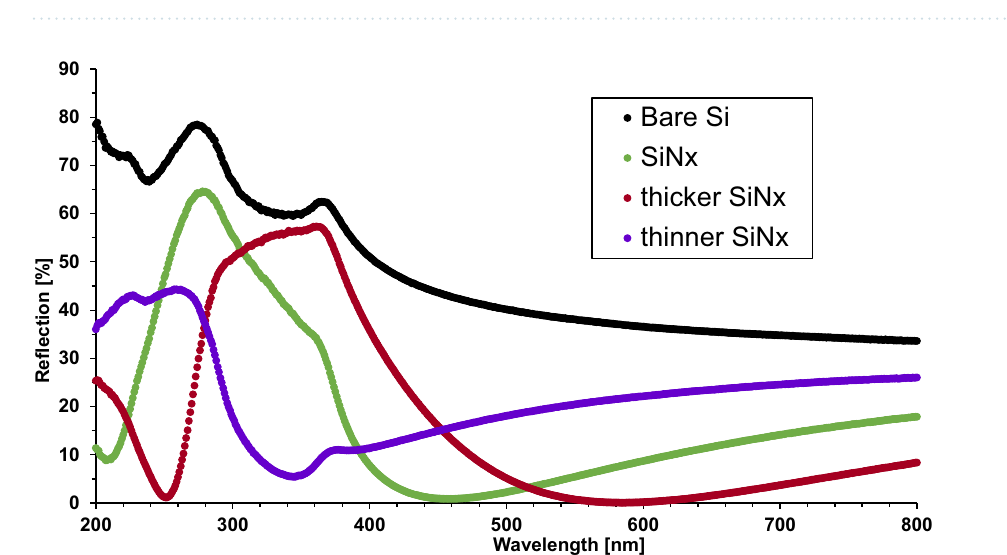
Figure 2. Reflection comparison of SiN x (55 nm), “thicker” SiN x (72 nm), and “thinner” SiN x (38 nm) as single- layer ARC deposited on the silicon wafers with planar silicon surface. The case of without any ARC (“Bare Si”) is also concluded as a